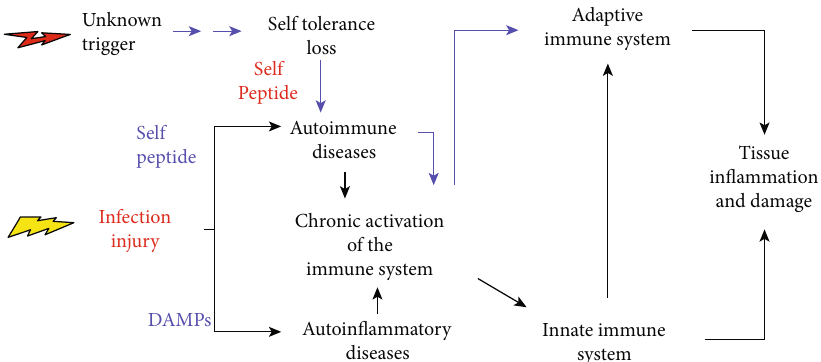
Figure 1: Simpli fi ed representation of the relative contribution of autoimmune, autoin fl ammatory, and mixed-pattern forms to tissue damage. DAMPs: damage-associated molecular